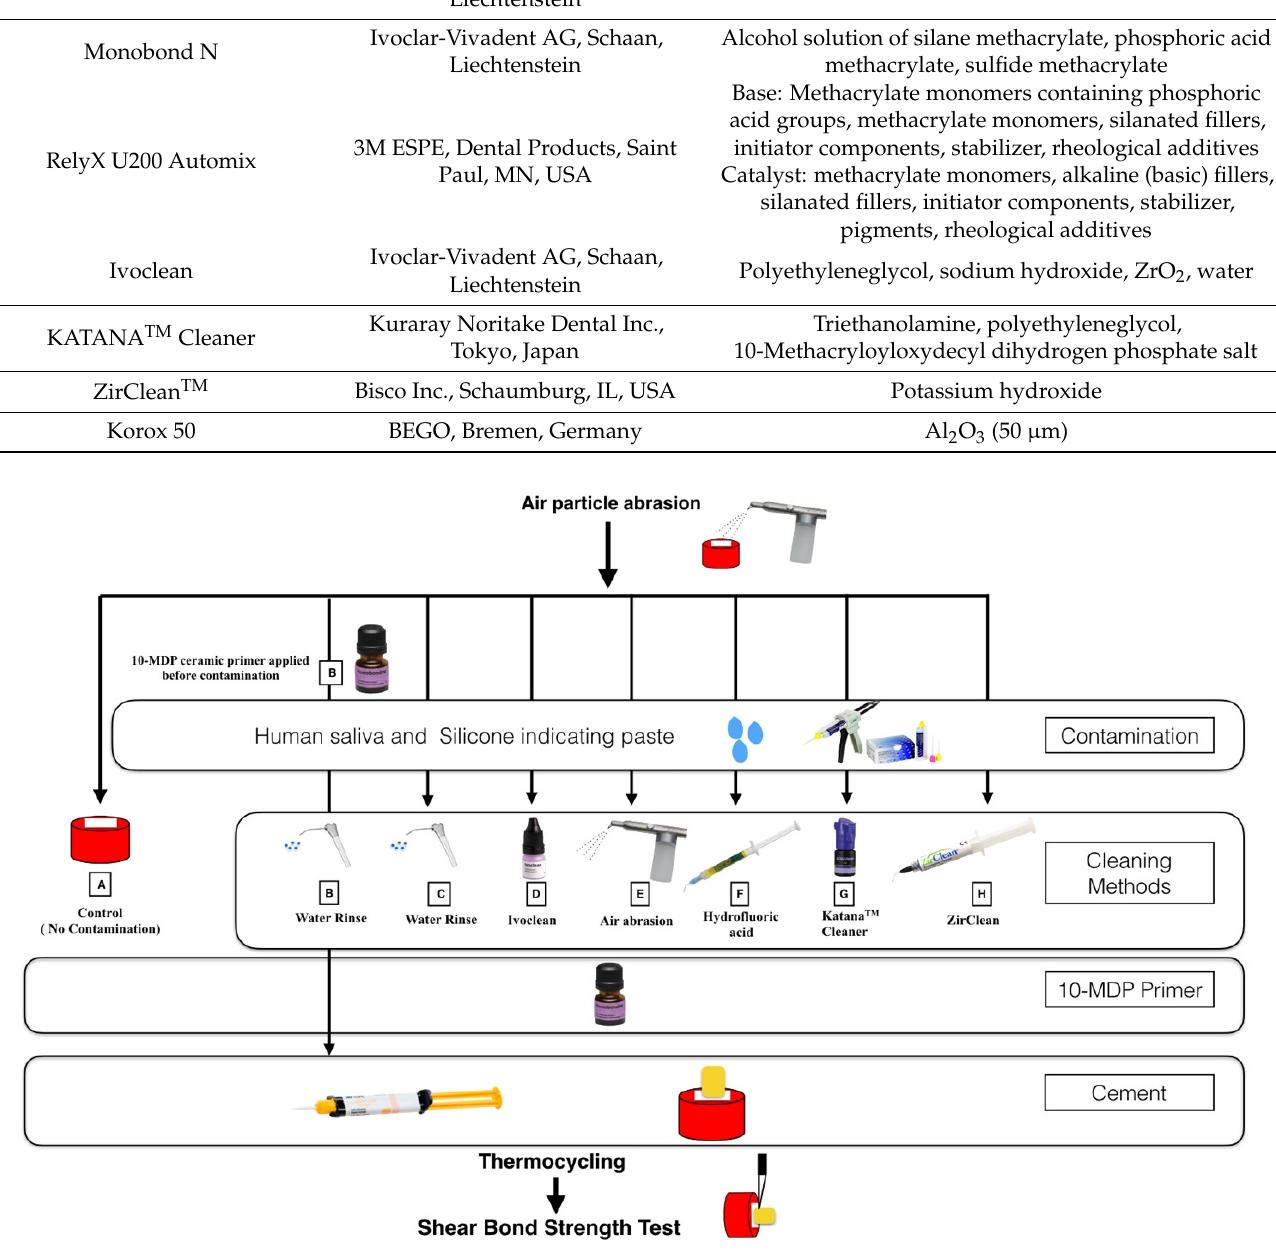
Figure 1. Flowchart of the test groups and cleaning methods. Shear bond strength (SBS) was measured using the universal testing machine (IN- STRON, Norwood, MA, USA). The load was applied to the interface of the zirconia-resin cement at a crosshead speed of 1 mm/min until failure (Figure